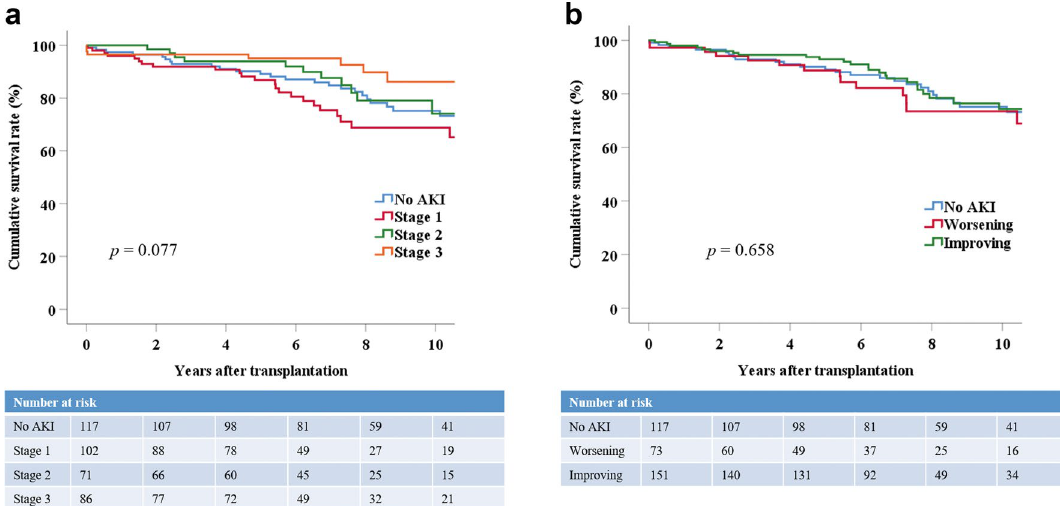
Figure 2. Death-censored graft survival stratified by AKI severity and trend. ( a ) Death-censored graft survival stratified by AKI severity. Group comparisons were performed using the Kaplan–Meier and log-rank tests.